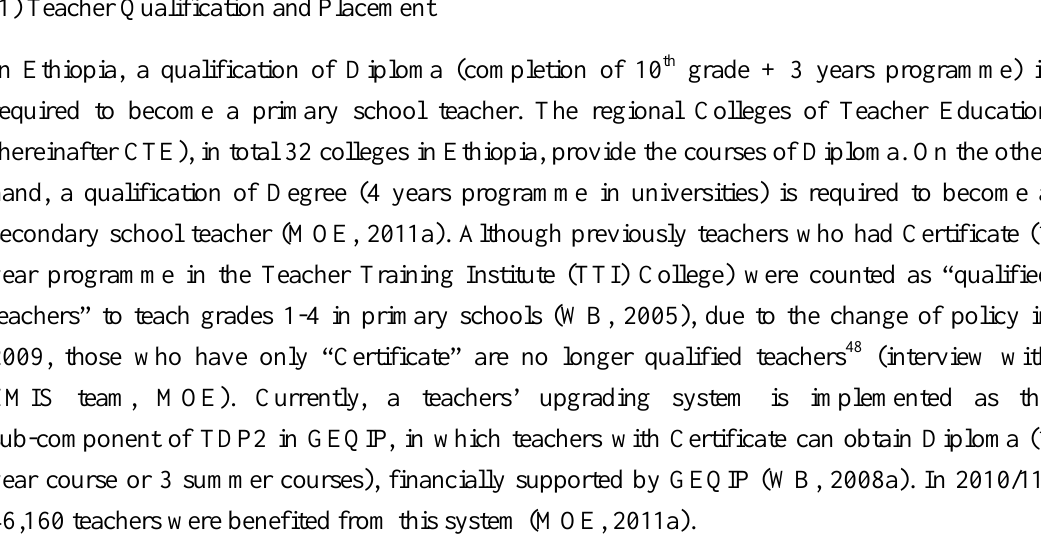
(Source: MOE, 2005, 2006, 2011a) Figure 4-16: Number of Secondary (Grades 9 - 12) Teachers by Gender (2000/01 -